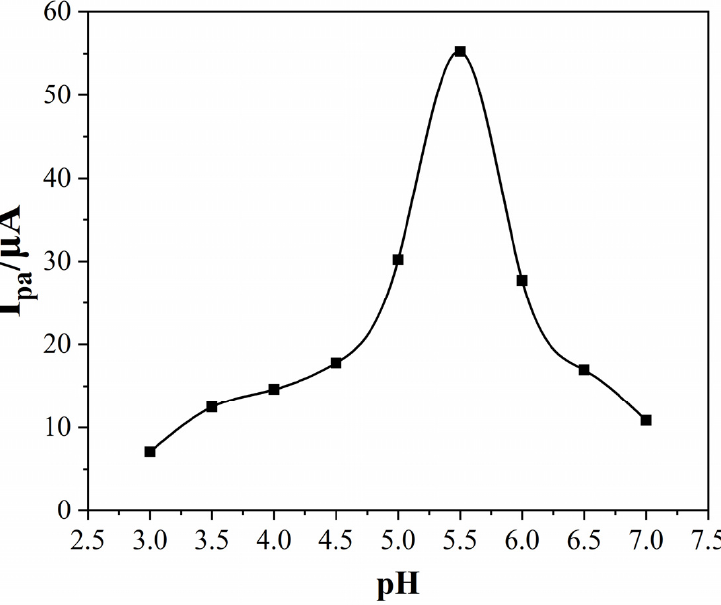
Figure 6. The effect of the solution pH on the I pa of 1.0 μ M of Pb 2+ . Deposition was applied at − 1.0 V for 300 s.